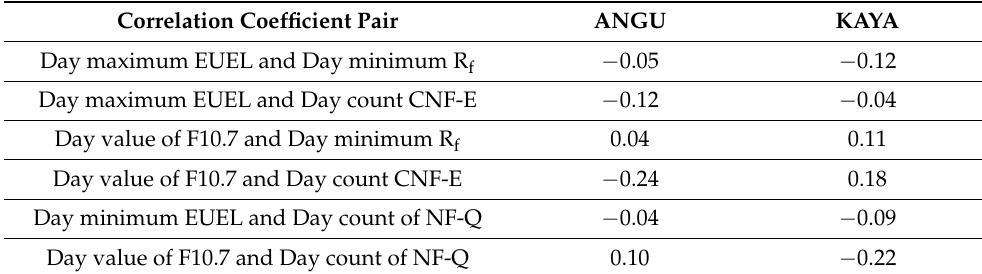
Figure 8. Power spectra density of EUEL at Davao Philippines (black) with units nT/cph, and power spectra density of range to feature (R f ) at ANGU (blue) and KAYA (orange) with units m/cph. Vertical lines indicate periods of peaks seen in the spectra. Table 3. Correlation Coefficient values between daily maximum value of EUEL and count of CNF-E feature occurrence and daily maximum value of EUEL and daily minimum R f